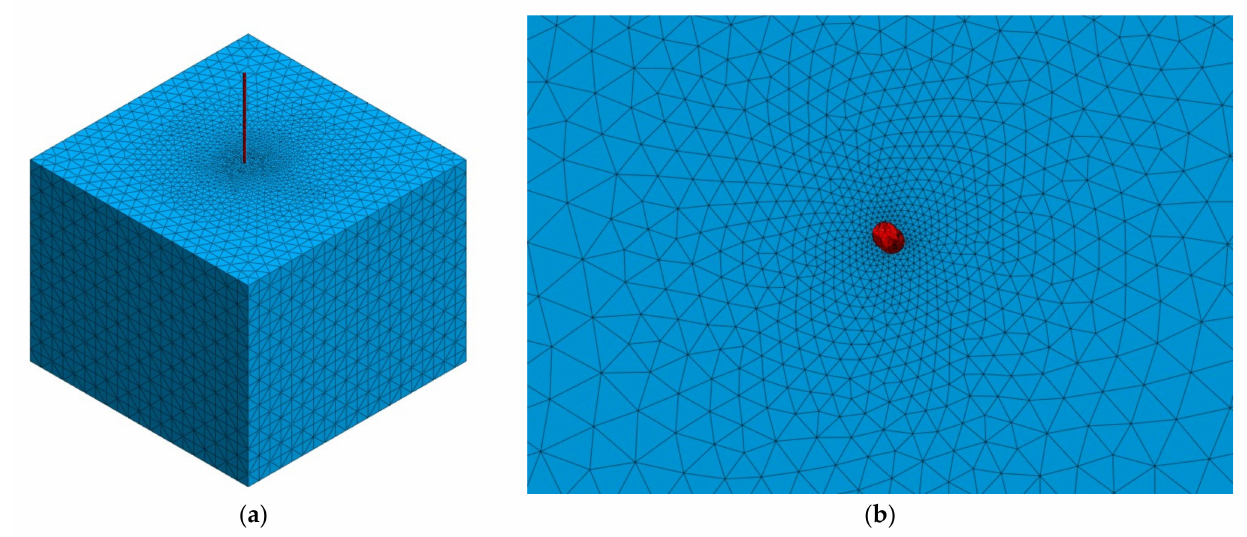
Figure 5. Mesh model: ( a ) isometric view of the mesh; ( b ) top view—finite element size progression.